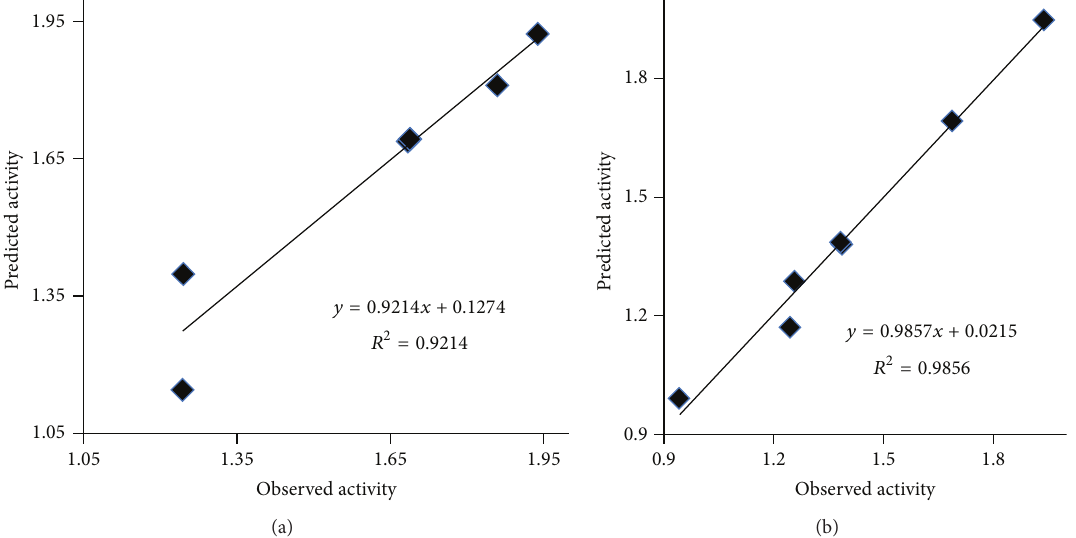
Figure 4: Plot of Predicted pMIC values against observed pMIC for QSAR model for (a) Escherichia coli and (b) Staphylococcus aureus.